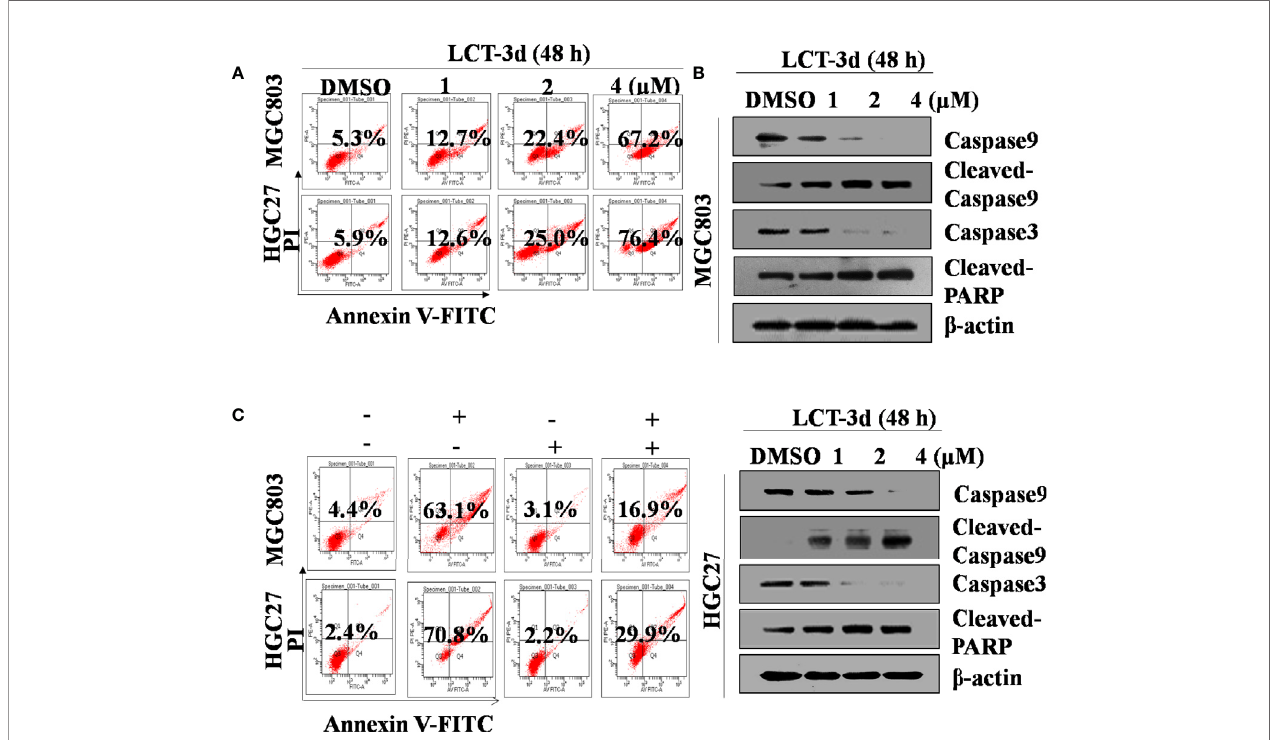
FIGURE 2 | LCT-3d triggered Caspase mediated apoptotic pathway in gastric cancer cells. (A) MGC803 cells and HGC27 were cells treated with various concentrations of LCT-3d for 48 h and apoptosis analyzed by fl ow cytometry. (B) Cells were treated as in (A) and the expression of Cleaved-Caspase and Cleaved PARP was analyzed by Western blotting. (C) MGC803 cells and HGC27 cells were pretreated with a pan-Caspase inhibitor, Z-VAD-FMK (100 m M) for 1 h, followed by incubation with LCT-3d (4 m M) for 48 h. Flow cytometric analysis on the effect of Z-VAD-FMK on LCT-3d-induced cells